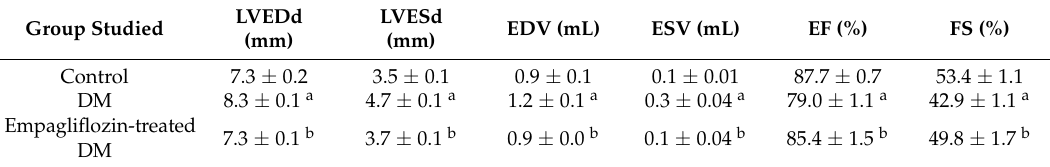
Table 2. Echocardiograms of control, diabetes mellitus (DM), and empagliflozin-treated DM rats at 16